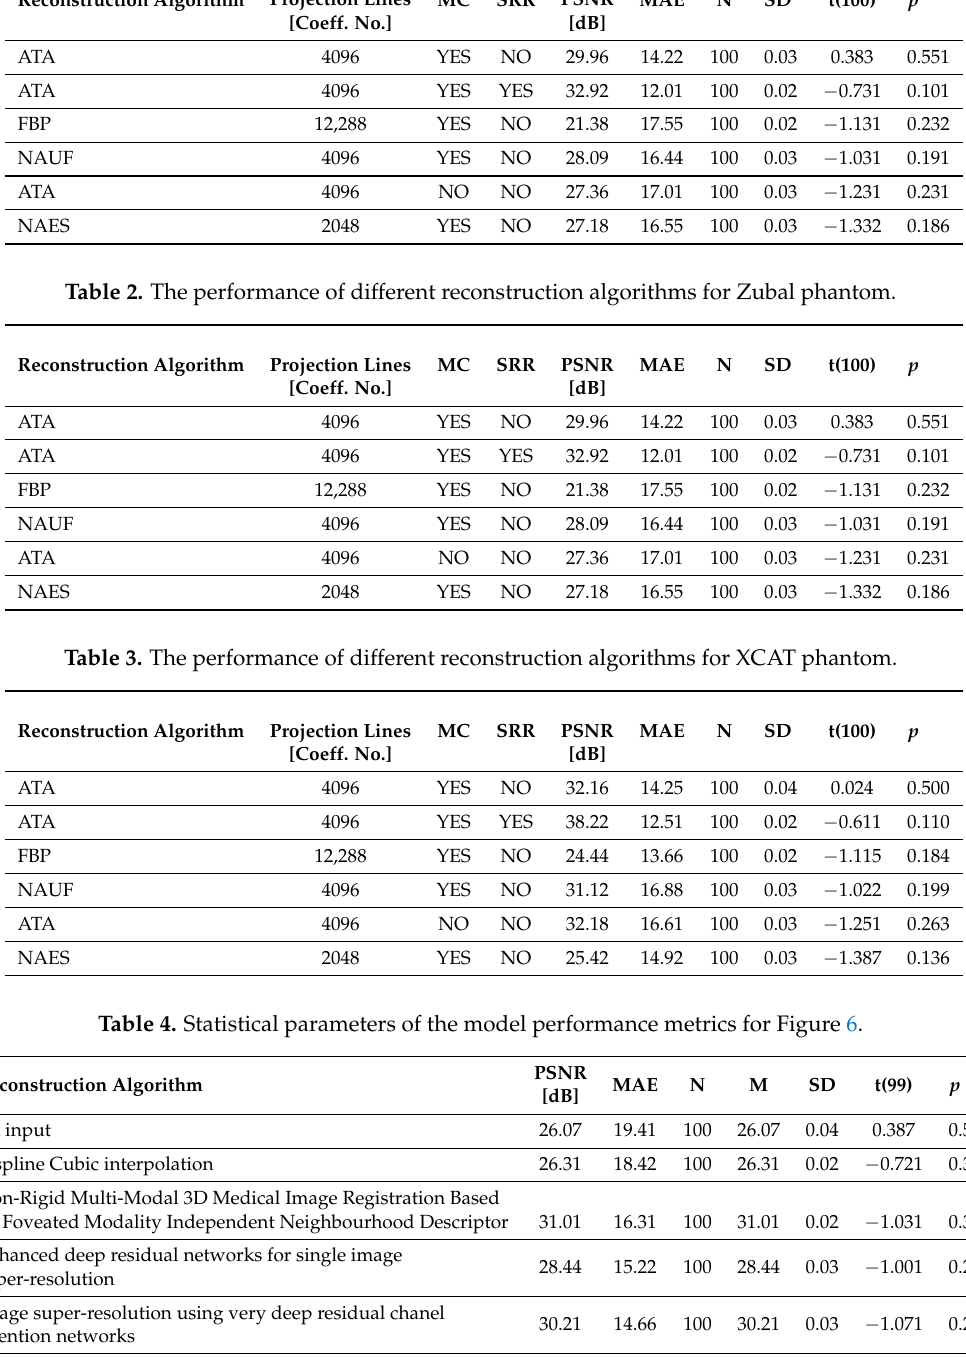
Table 1. The performance of different reconstruction algorithms for Shepp–Logan phantom. Reconstruction Algorithm